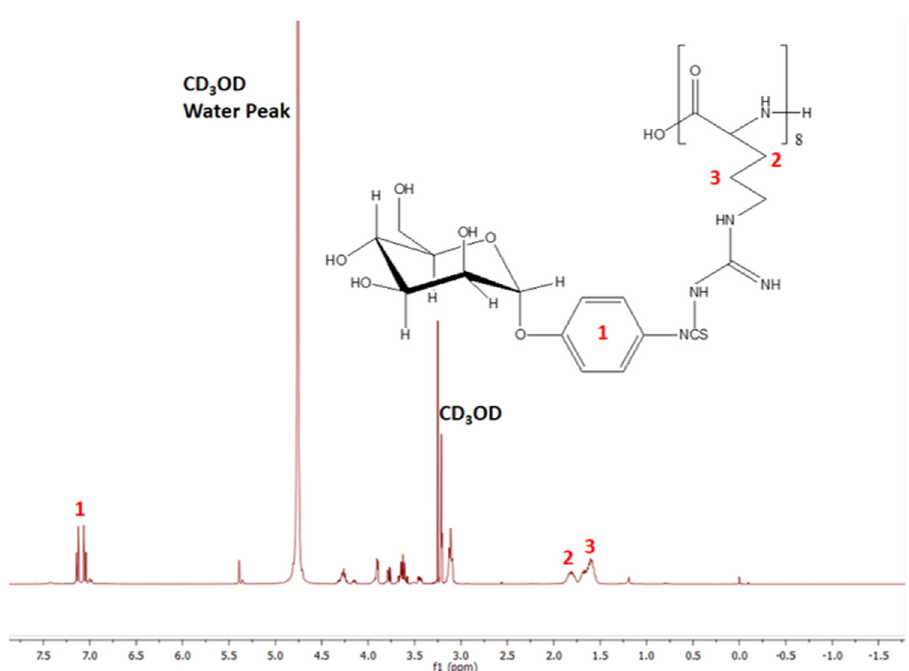
Figure 2. 1 H NMR spectrum of MPITC-R8 conjugate.